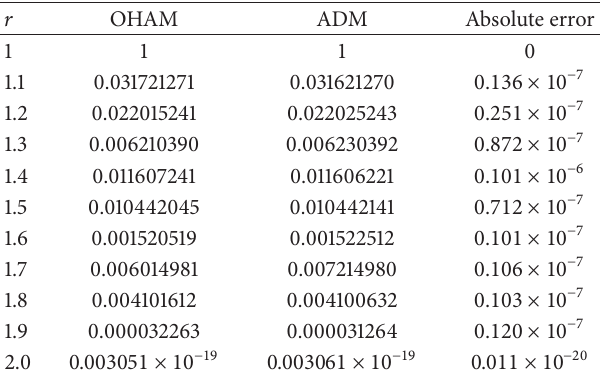
Table 2: Comparison of the present work with published work [12]